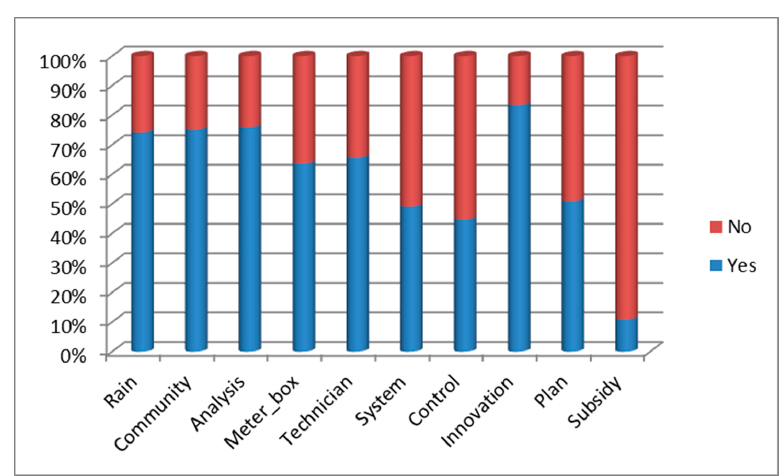
Figure 3. Results related to water usage.